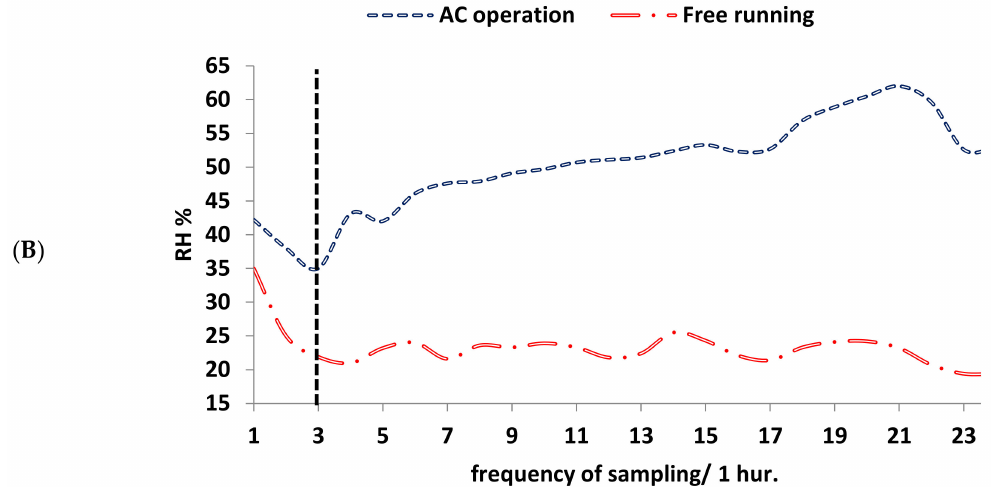
Figure 11. Comparison between ( A ) indoor air temperature and ( B ) relative humidity of underground constructed room.